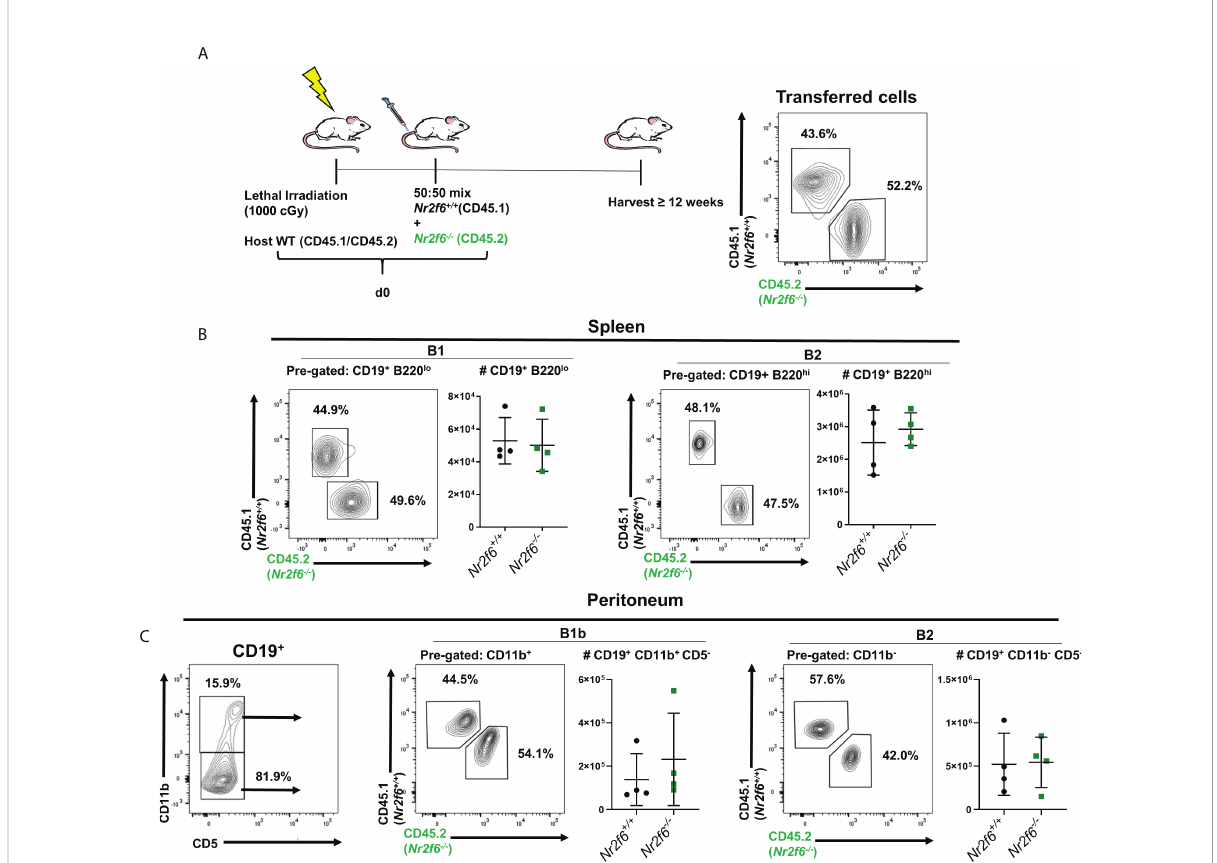
FIGURE 4 Nr2f6 -de fi cient bone marrow cells reconstitute the B cell peritoneum population of wild-type hosts with the same ef fi ciency as wild-type bone marrow. (A) Experimental scheme, CD45.1/CD45.2 host mice were lethally irradiated and on the same day a 50:50 mix of Nr2f6 +/+ (CD45.1) and Nr2f6 -/- (CD45.2) bone marrow was transferred intravenously, reconstitution was allowed to occur for at least 12 weeks after which splenic and peritoneal B cell populations were identi fi ed by fl ow cytometry. (Far right) a representative CD45.1/CD45.2 stain of the bone marrow mix used for reconstitution. (B) After reconstitution, splenic B1 and B2 cells were investigated using CD19 and B220 expression. FACS plots show representative frequencies of each genotype and graphs show total cell counts of each population. (C left panel ) Staining of CD11b and CD5 on CD19 + B cells isolated from the peritoneum. (C center and right panels ) frequency and total numbers of Nr2f6 +/+ or Nr2f6 -/- cells from the indicated peritoneal B cell population. Each data point represents an individual mouse, data shown are from three individual experiments. For most data sets statistical signi fi cance was determined using a two-tailed student t-test however, all data were tested for normality by Shapiro-Wilk testing, and for non- normally distributed data signi fi cance was determined using a Mann-Whitney U test. Within this fi gure, (C) B1b total cell count was not normally distributed and was tested by a Mann-Whitney U test, the data was not signi fi cantly different between the